Question: Describe this figure in one sentence.
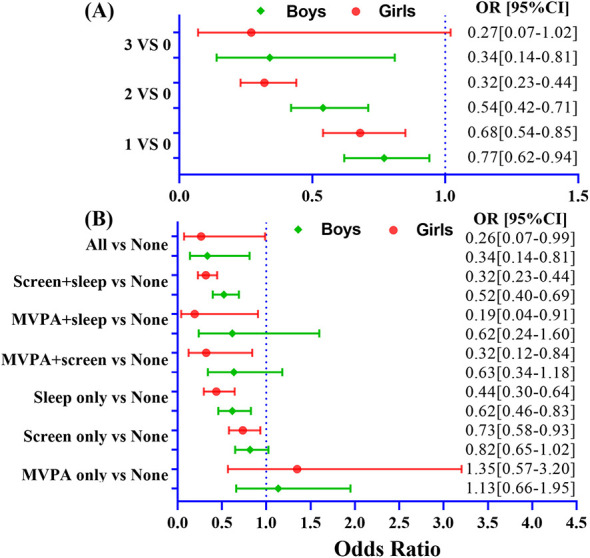
Answer: Associations between adherence to 24-h movement guidelines and NSSI by sex. (A) ORs (95% CIs) for NSSI by number of met guidelines. (B) ORs (95% CIs) for NSSI by guideline combinations. OR, odds ratio; CI, confidence interval.